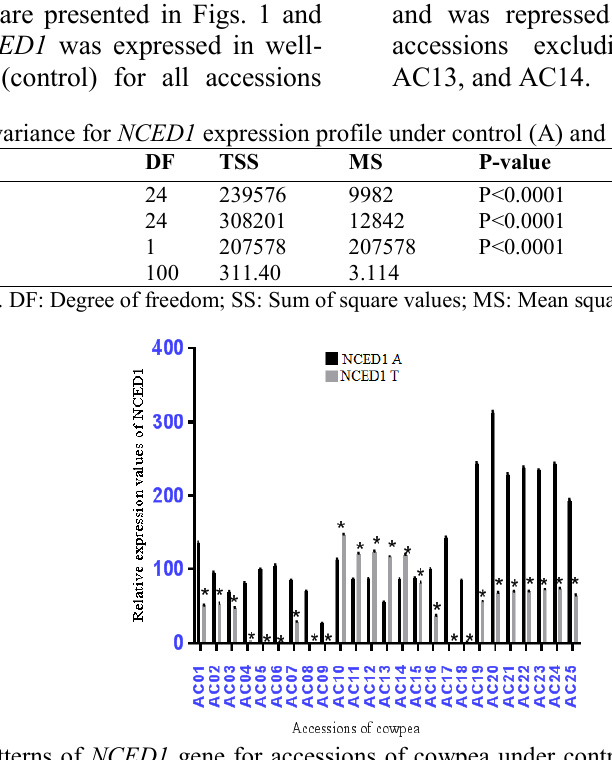
Fig. 1. Expression patterns of NCED1 gene for accessions of cowpea under control (A) and drought-stressed (T) conditions. AC01- AC25 are accessions of cowpea. Each bar represents the mean value ± standard error (n = 3, where n represents the number of replicates). Means marked with ‘*’ indicate significant differences between treatments at P ˂ 0.0001 according to Tukey’s multiple comparisons test.